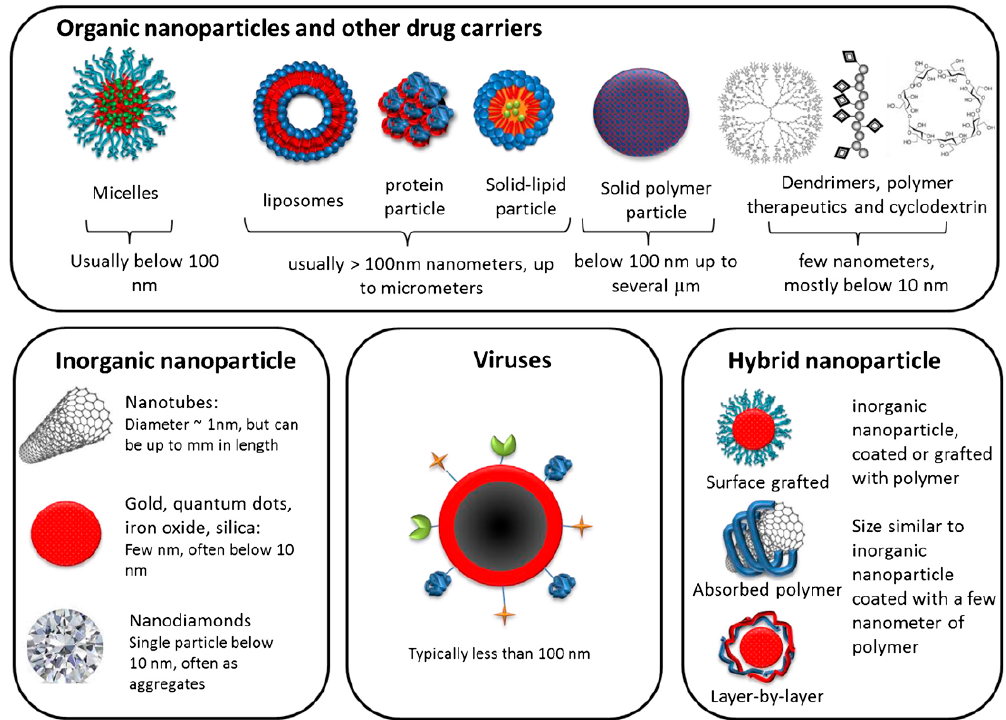
Figure 4. Nanoparticle illustrations that exist in both soft and hard (Reproduced with permission from [1]. Copyright Elsevier,